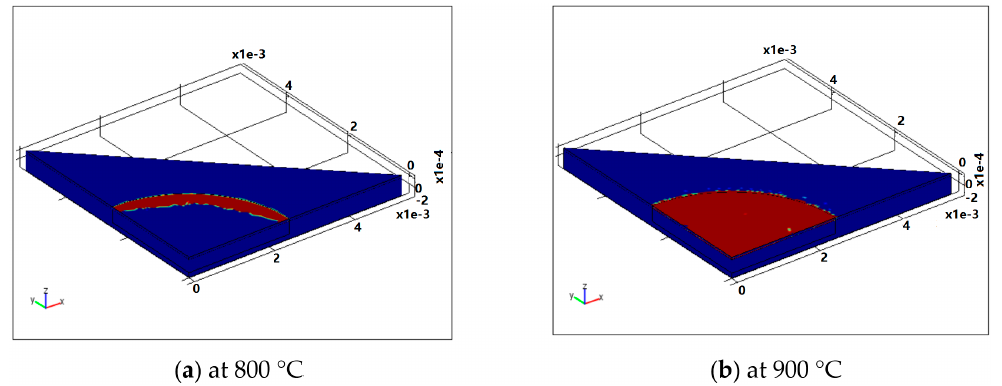
Figure 6. Plastic zones in the diaphragm at temperature of ( a ) 800 °C and ( b ) 900 °C with a radius of 2.5 mm (illustrated by red color) predicted by FEA model.